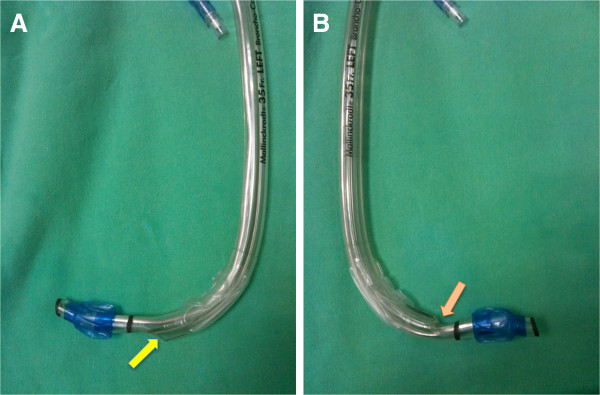
Directions of angulation of the double-lumen endobronchial tube. A. Angulation leaving the tracheal orifice exposed (TOE group). B. Angulation concealing the tracheal orifice (tracheal orifice concealed, TOC group). The distal tracheal orifice is indicated by the arrow.